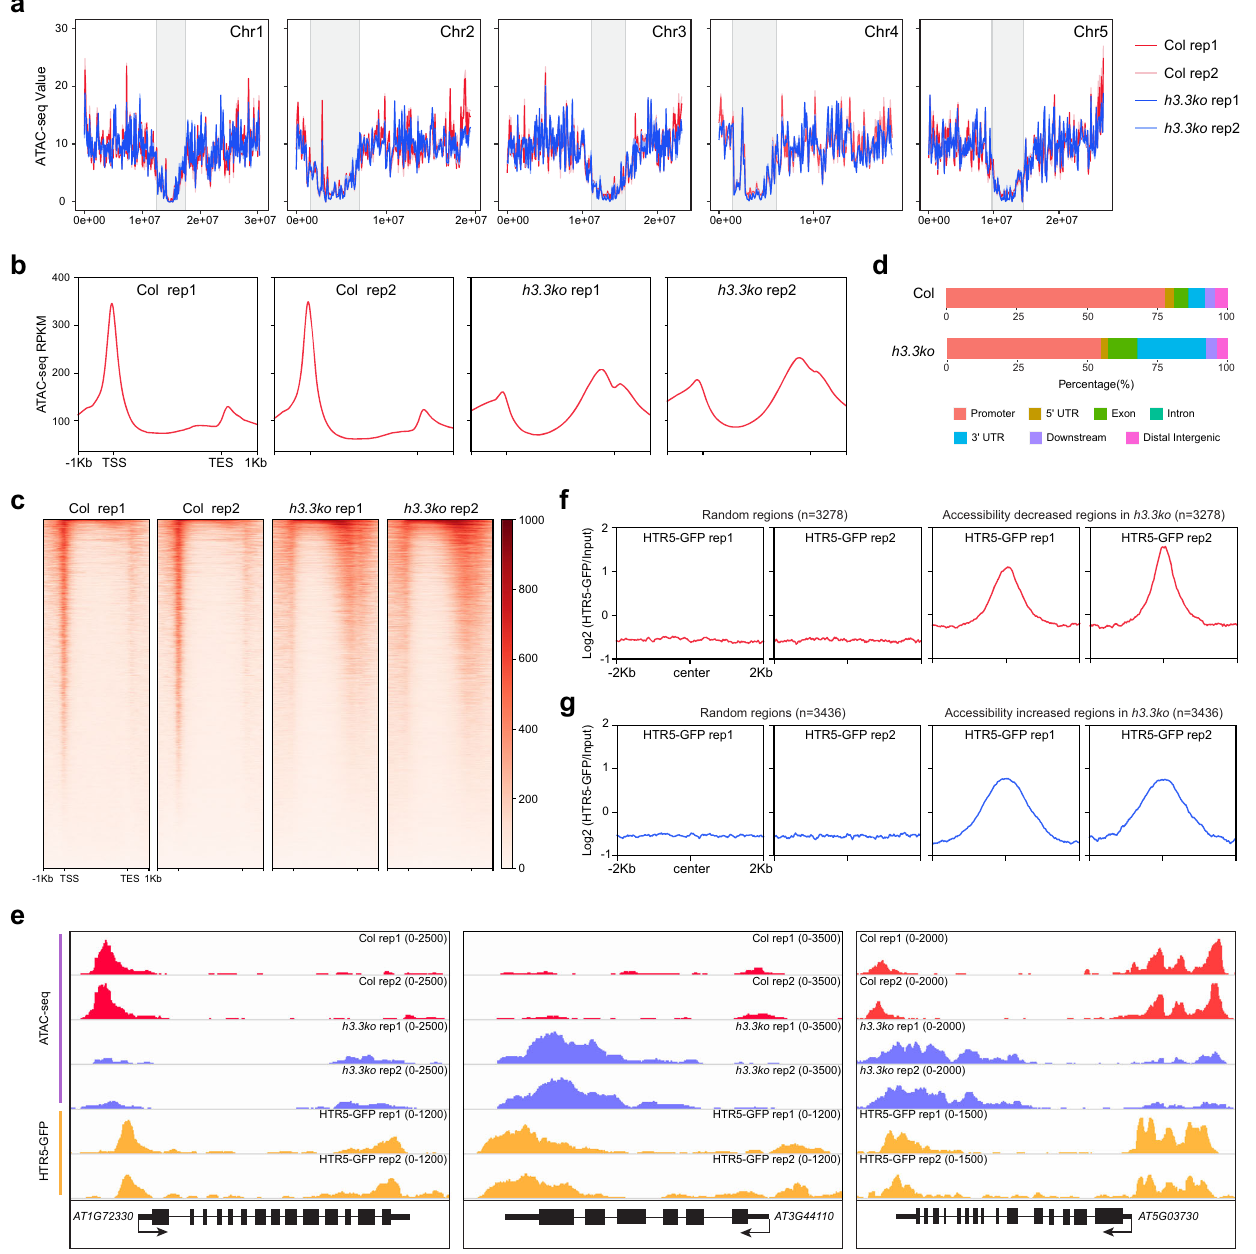
Fig. 4 | Chromatin accessibility changes in mature h3.3ko seeds. a ATAC-seq signals in Col and h3.3ko mature seeds over Arabidopsis chromosomes. Signals were calculatedin100kbbins.Pericentromericheterochromatinregionsareindicatedwith gray shading. b Metaplot of ATAC-seq signals in Col and h3.3ko mature seeds over all genes. c Heatmap of ATAC-seq signals in Col and h3.3ko mature seeds over all genes. d Genomic distribution of accessible regions in Col and h3.3ko mature seeds. e GenomebrowserviewofATAC-seqandHTR5-GFPChIP-seqsignalsinColand h3.3ko